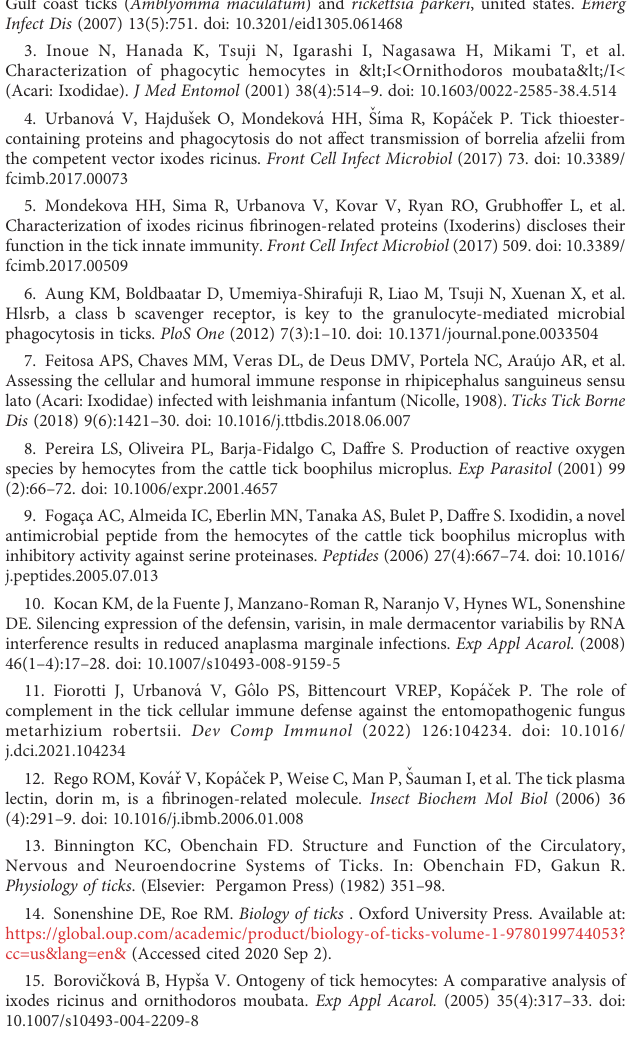
SUPPLEMENTARY FIGURE 2 (A, B) Confocal images of phagocytic hemocytes infected with Rickettsia parkeri . Representative confocal images of immuno fl uorescence staining for R. parkeri Sca2 protein in hemolymph of R. parkeri- infected Am. maculatum. Hemocytes were either (A) permeabilized with Triton-X or (B) not permeabilized before incubation with Sca2- speci fi c antibodies (red) and Hoechst 33342 (blue). SUPPLEMENTARY FIGURE 3 LysoTraker Red labeling of lysosomal compartments in ticks fed with R. parkeri . Fluorescent microscopic images of hemocytes from R. parkeri infected ticks stained with LysoTracker Red (a lysosomal marker) 24 hours after infection. Hemocytes were incubated with primary antibodies against R. parkeri outer membrane protein (green) and Hoechst 33342 (blue). Scale bar = 10 m m. SUPPLEMENTARY FIGURE 4 (A, B) Heatmaps of RNA-seq expression data showing hematopoietic and cellular function genes differentially regulated in R. parkeri- infected compared with uninfected hemocytes. Several of these transcripts include (A)